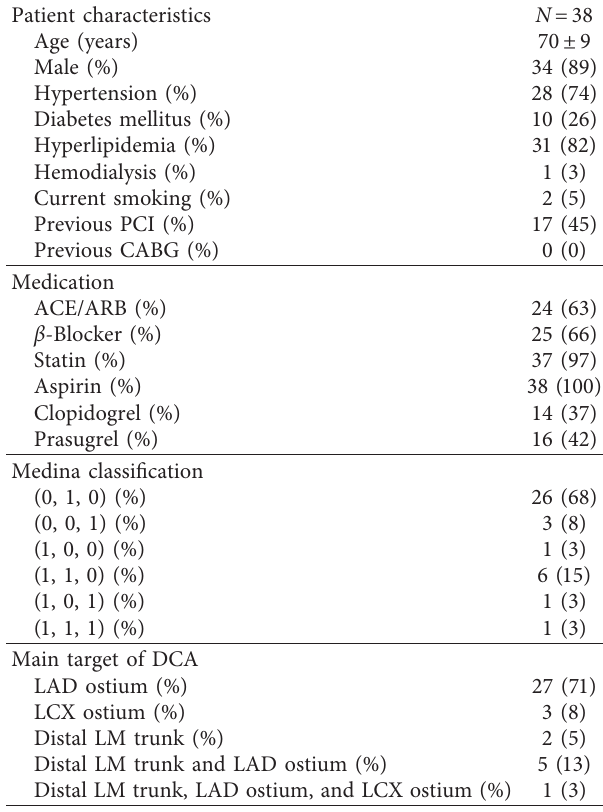
Table 1: Baseline characteristics.